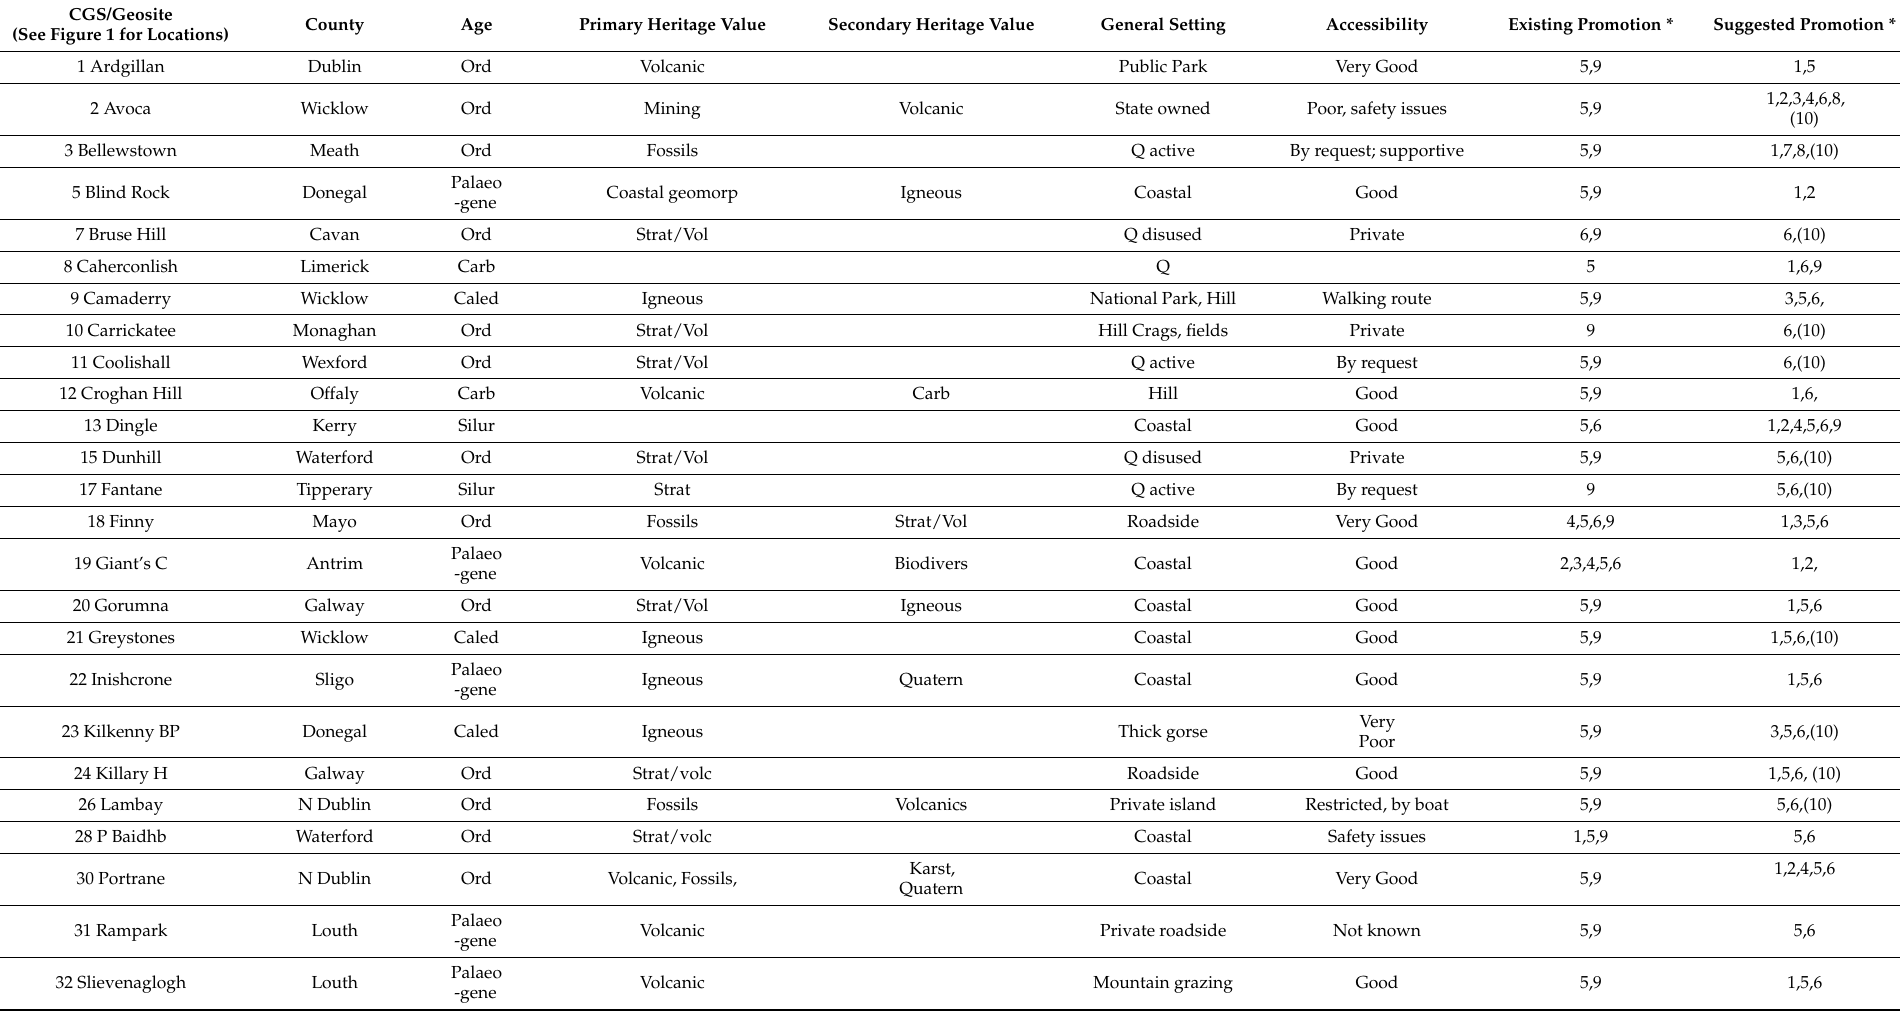
Table 1. Selection of the main volcanic sites in Ireland with suggested interpretation and